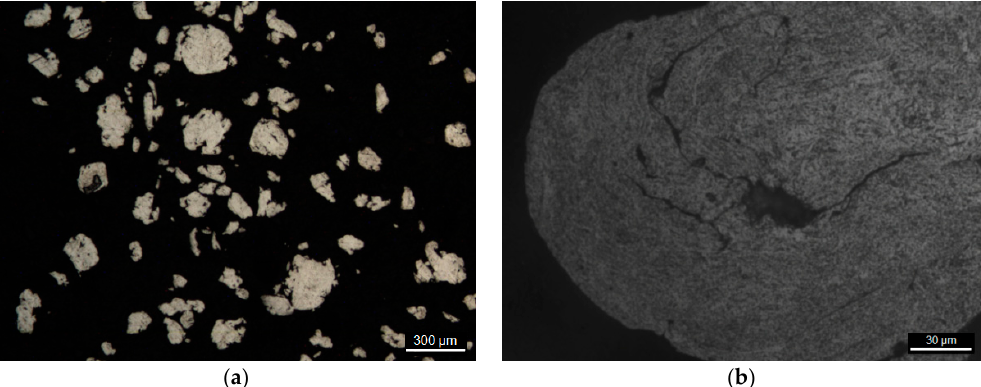
Figure 8. Structural characteristics of the composite particle microstructure. Microscope magnification ×50 ( a ) and ×500 ( b ).